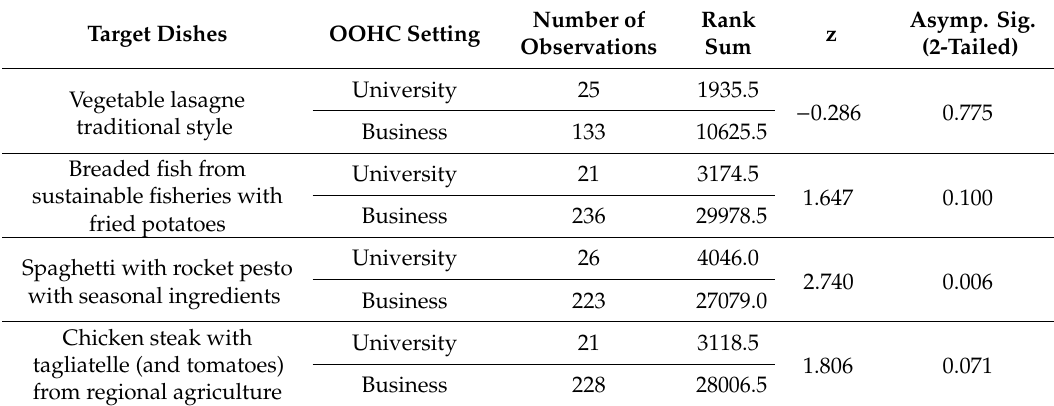
Table 10. Mann − Whitney U Test for OOHC setting comparison of the combined DNLs and DE